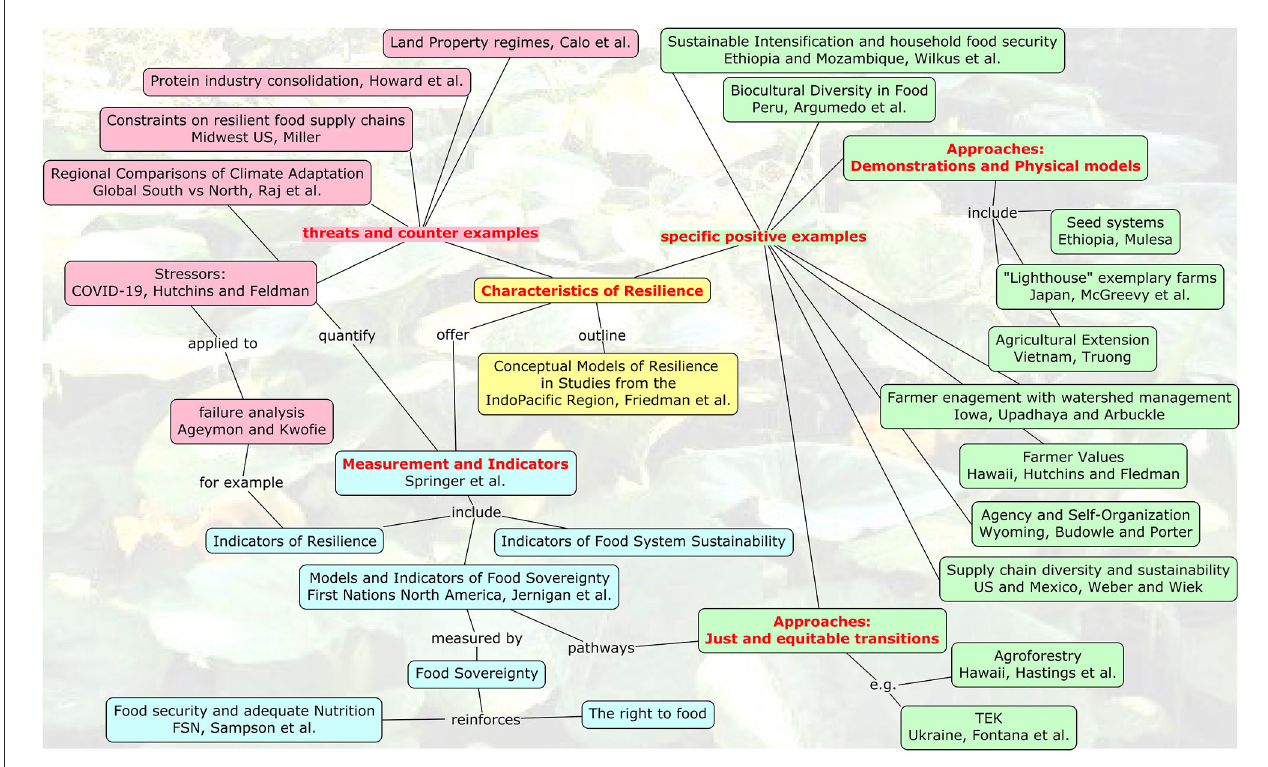
FIGURE1 Concept map of the papers submitted to address the special Research Topic on food system resilience and equity under global environmental